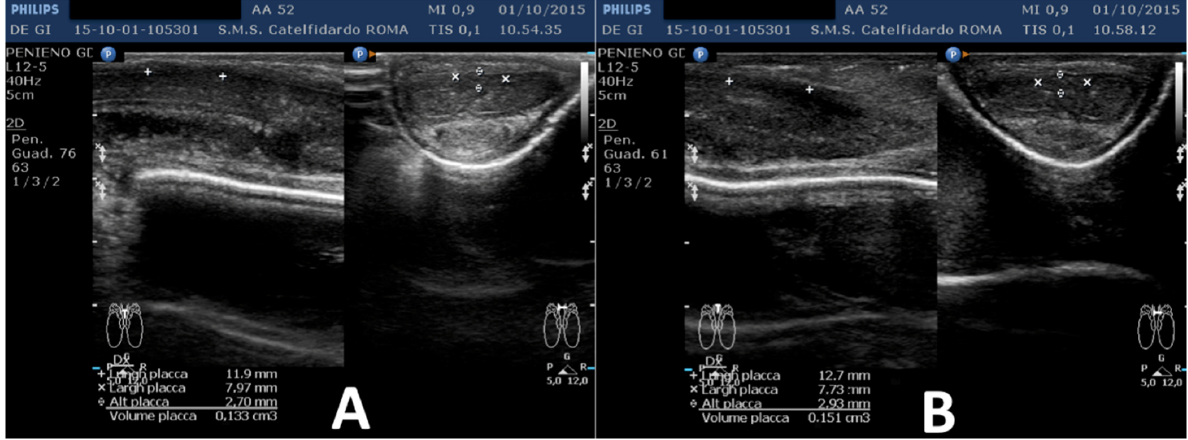
6 Figure 6. Ultrasonography of the penis and plaque measurement before treatment (longitudinal and transverse views). ( A ) First plaque, ( B ) second plaque. When gathering the patient’s informed consent, the patient was forewarned that the treatment would be lengthy, considering the disease’s chronicity. The patient did not au ‐ thorize the publication, however anonymous, of photographs of his penis. In March 2015, the patient provided his informed consent and began the following combined treatment: oral propolis 600 mg + bilberry 160 mg + silymarin 400 mg + ginkgo biloba 250 mg + L ‐ carnitine 1000 mg + coenzyme Q10 100 mg + Boswellia 200 mg + vitamin E 30 mg/daily; topical diclofenac gel 4%/2× per day; pentoxifylline 100 mg periplaque injection (with a 30G needle) every two weeks for six months. In order to minimize trauma to the penile tissues, penile injections with pentoxifylline were performed in a perilesional fashion (and not inside the plaque). For the same reason, a very thin needle (30 G) was used. Having ended his first therapy cycle, the patient was followed up with the same ex ‐ amination process as previously. His IIEF score had risen to 27. A dorsal penile curvature